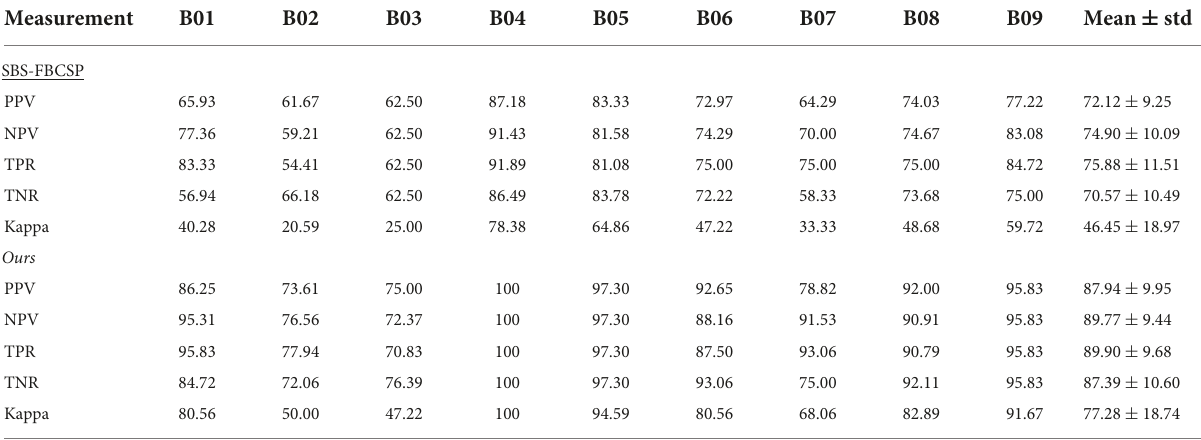
TABLE 6 Performance comparison between SBS-FBCSP and our method, using dataset 2.